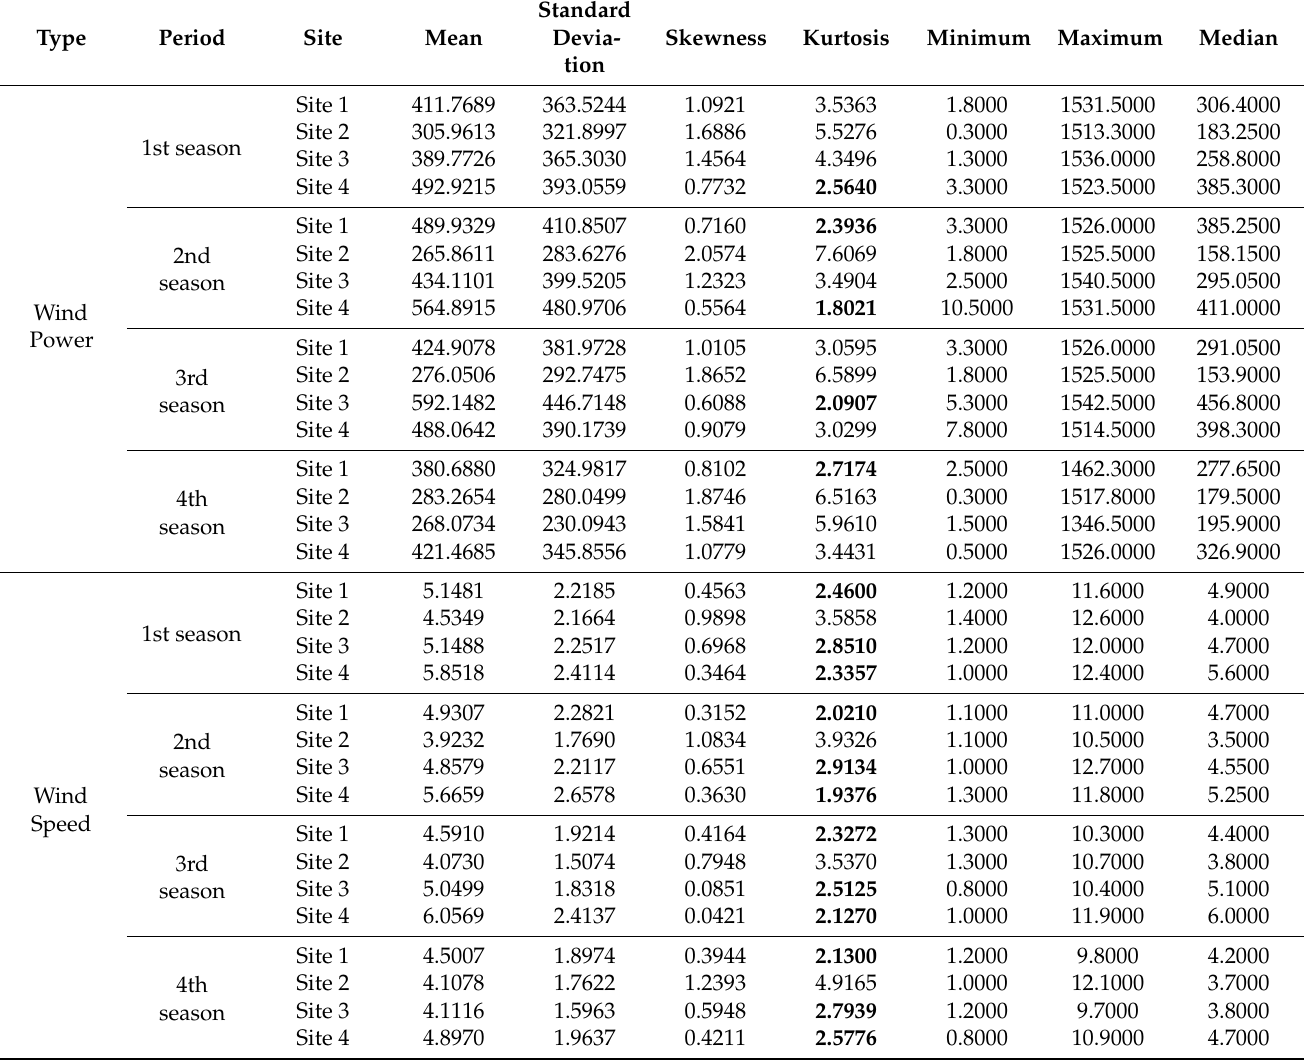
Table 1. Statistical descriptions for wind speed and wind